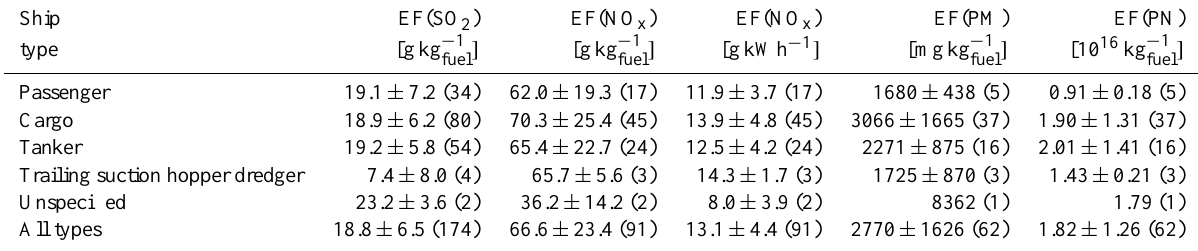
Table 5. Emission factors of SO 2 , NO x and particulate matter emissions for different ship types. The presented numbers are the mean values and standard deviations for each ship type of the average for each plume over several transects. The number in brackets is the number of plumes that have been traversed. The same ships may appear twice if they were measured on several occasions.